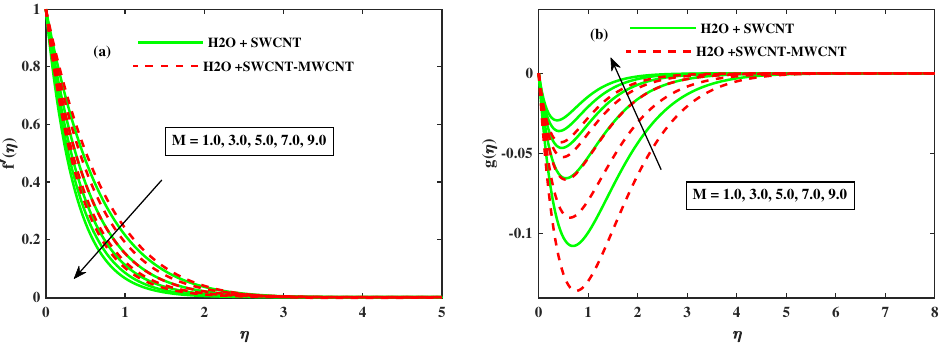
Figure 3. Effect of M on velocity profile ( a ) along the x -direction and ( b ) along the y